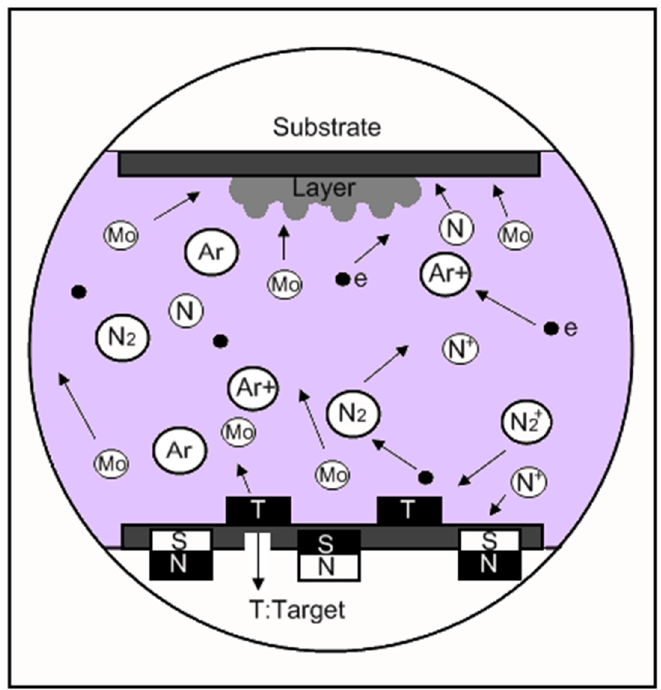
Figure 1. Experimental set up of magnetron sputtering